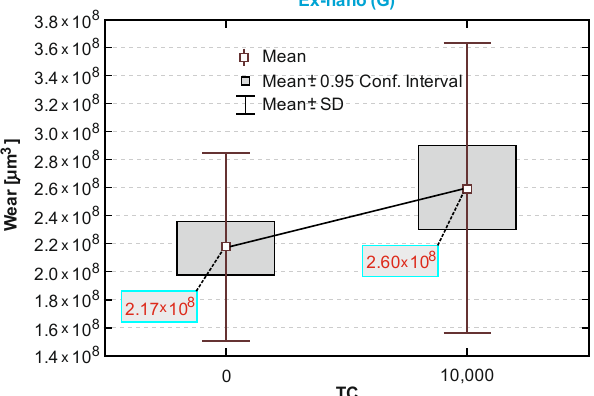
Figure 11. A box-and-whiskers plot of the wear resistance of the N-fill-flow composite.